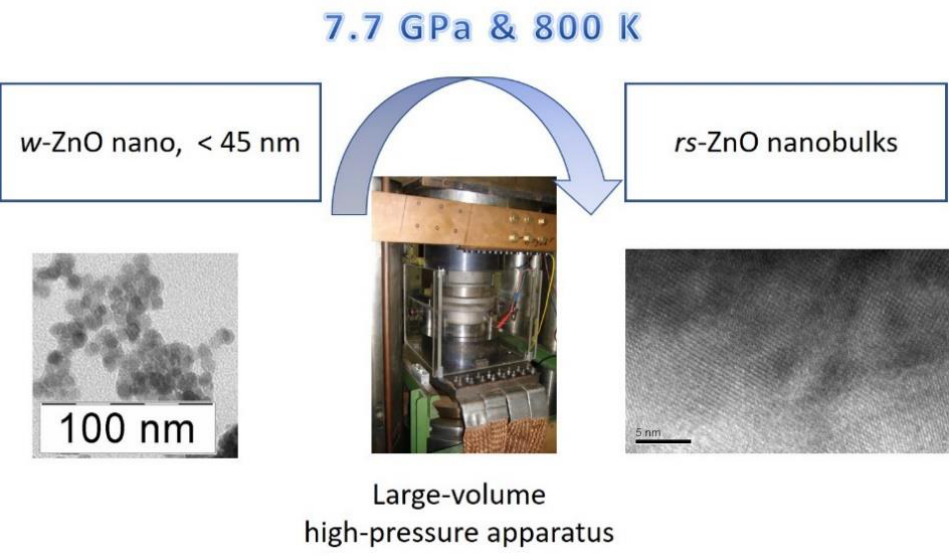
Figure 5. Synthesis scheme for single-phase rs-ZnO nanobulks.